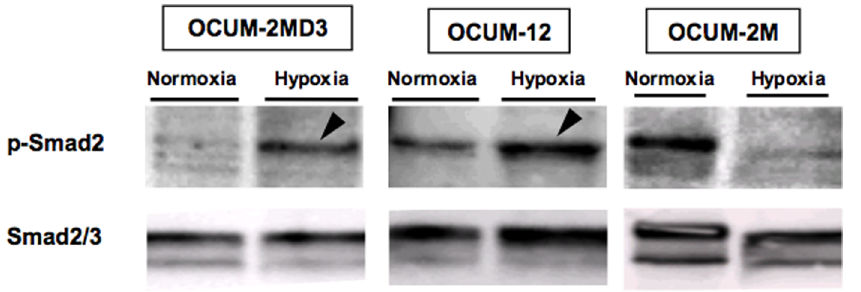
Figure 4. Smad2 phosphorylation of gastric cancer cells under a hypoxic condition. Hypoxic condition for 24 h increased Smad2 phosphorylation of OCUM-2MD3 and OCUM-12 cells (arrowheads), but not that of OCUM-2M cells. Smad2/3 was used as an international control for